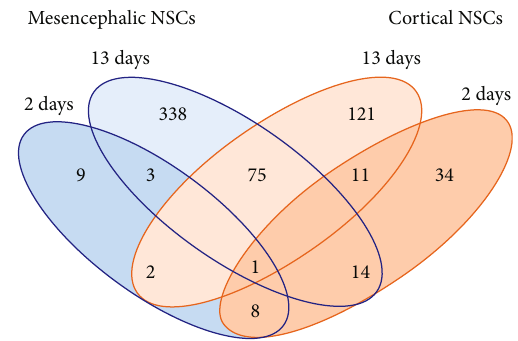
Figure 2: Comparison of di ff erentially expressed genes in short- versus long-term physioxia of mesencephalic and cortical NSC cultures. The 4-way Venn diagram shows total numbers of O regulated genes when comparing mesencephalic with cortical NSCs and short- (2 days) versus long-term O